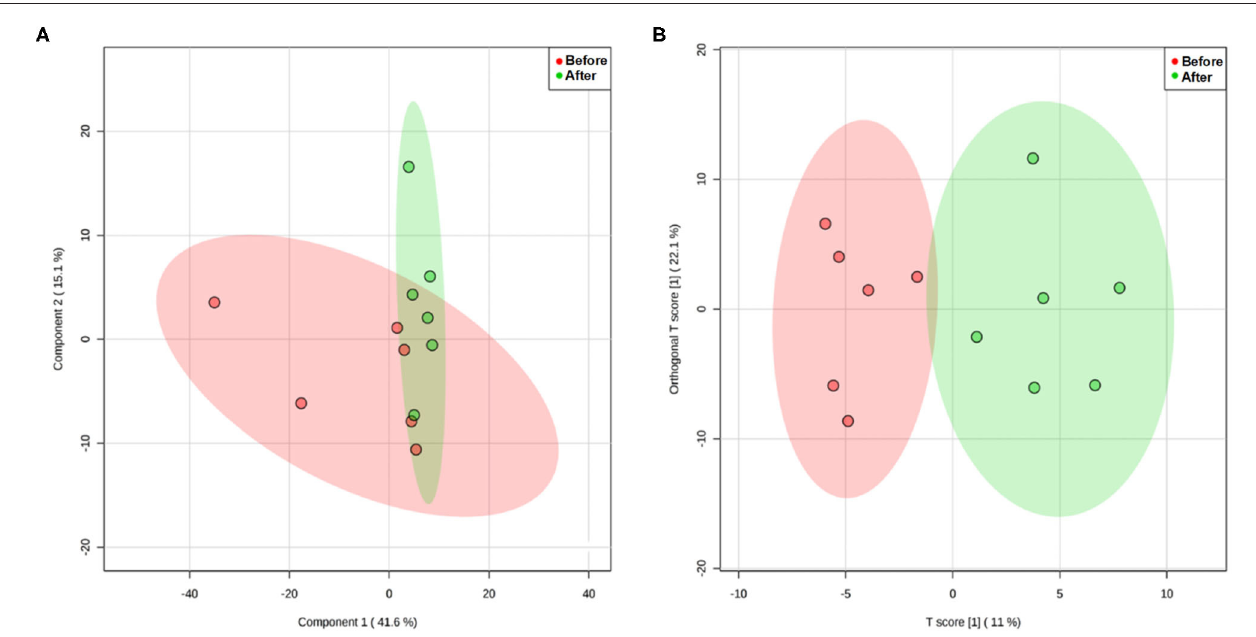
FIGURE 2 | Analysis of PLS-DA (A) and O-PLS-DA (B) showing the distinction between the profile of total salivary metabolites before and after cleaning the oral mucosa of infants in the pre-dental period.